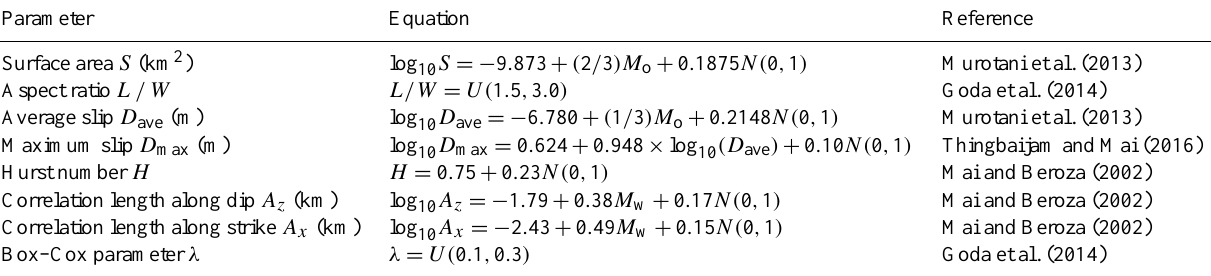
Table 1. Summary of empirical scaling laws and probabilistic information of fault geometry and stochastic source parameters adopted in this study. N (0,1) represents the standard normal random variable, whereas U ( a , b ) represents the uniform random variable with lower and upper limits of a and b ,